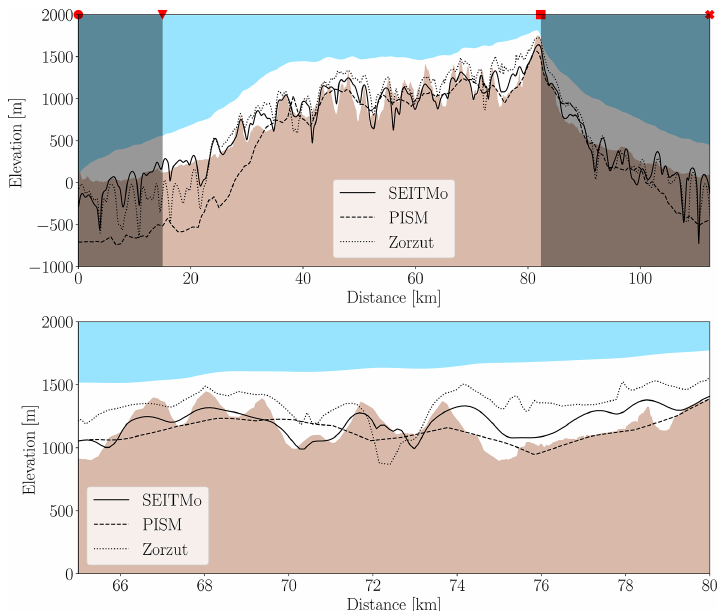
Figure 2. OIB cross section with the SEITMo, PISM, and Zorzut bedrocks and red distance marks in the top as marked in Fig. 1. The outline of the ice cap is based on surface elevation from ArcticDEM and OIB ice